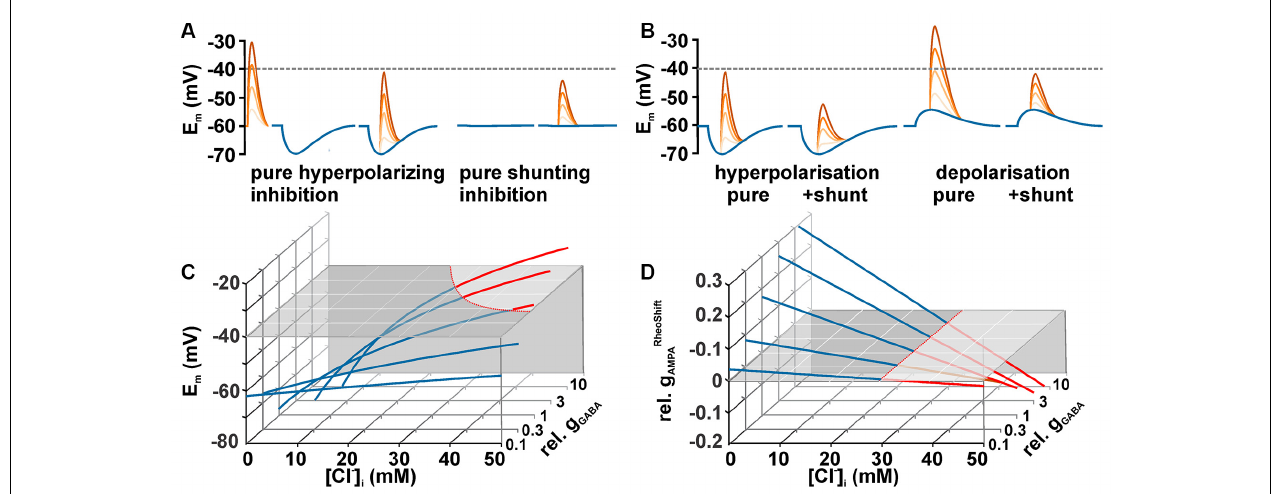
FIGURE 2 | Dependency between [Cl − ] i and GABAergic actions. (A) Schematic diagrams illustrating the two exemplary effects of GABAergic inputs (blue traces) on glutamatergic inputs (red traces) of different intensities. A GABAergic hyperpolarization augments the distance between peak glutamate depolarization and the AP threshold (hyperpolarizing inhibition). At a passive Cl − -distribution GABA does not affect E m , but the decreased membrane resistivity induced by GABA reduced the peak glutamate depolarization (shunting inhibition). The dashed line represents a hypothetical action potential threshold. (B) Schematic diagrams illustrating that the combination of the membrane potential shift with the shunting effect caused by the decreased membrane resistivity augments the effect of a hyperpolarization inhibition (left traces) and can lead to inhibition even at depolarizing GABAergic membrane responses (right traces). (C) [Cl − ] i -dependency of the membrane potential (E m ) calculated for five different GABAergic conductances (g GABA , normalized to g Input ) under stationary conditions (see main text for details). The gray plane represents AP threshold. Note that considerable g GABA in combination with high [Cl − ] i is needed for a suprathreshold GABAergic depolarization. (D) Dependency of g AMPARheoshift (normalized to g Input , ; g AMPARheoshift =gAMPA in presence of GABA minus gAMPA in absence of GABA) on [Cl − ] i and g GABA . Red traces indicate excitatory and blue traces inhibitory GABAergic effects. Note that g GABARheoshift becomes negative at identical [Cl − ] i independent of g GABA .